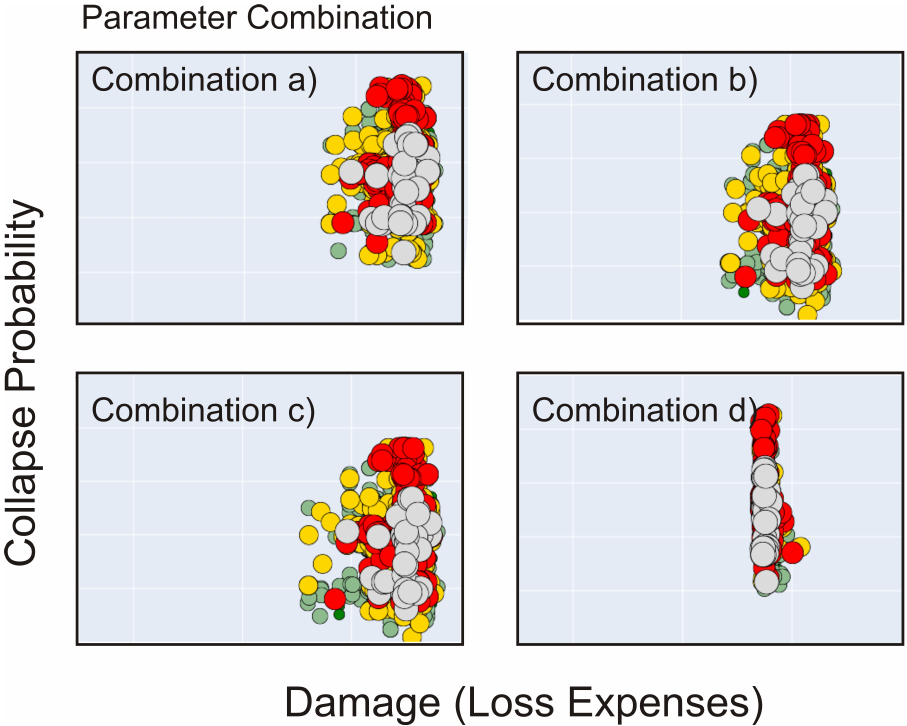
Figure 4. Sensitivity analysis I (the colour indicates the condition class).